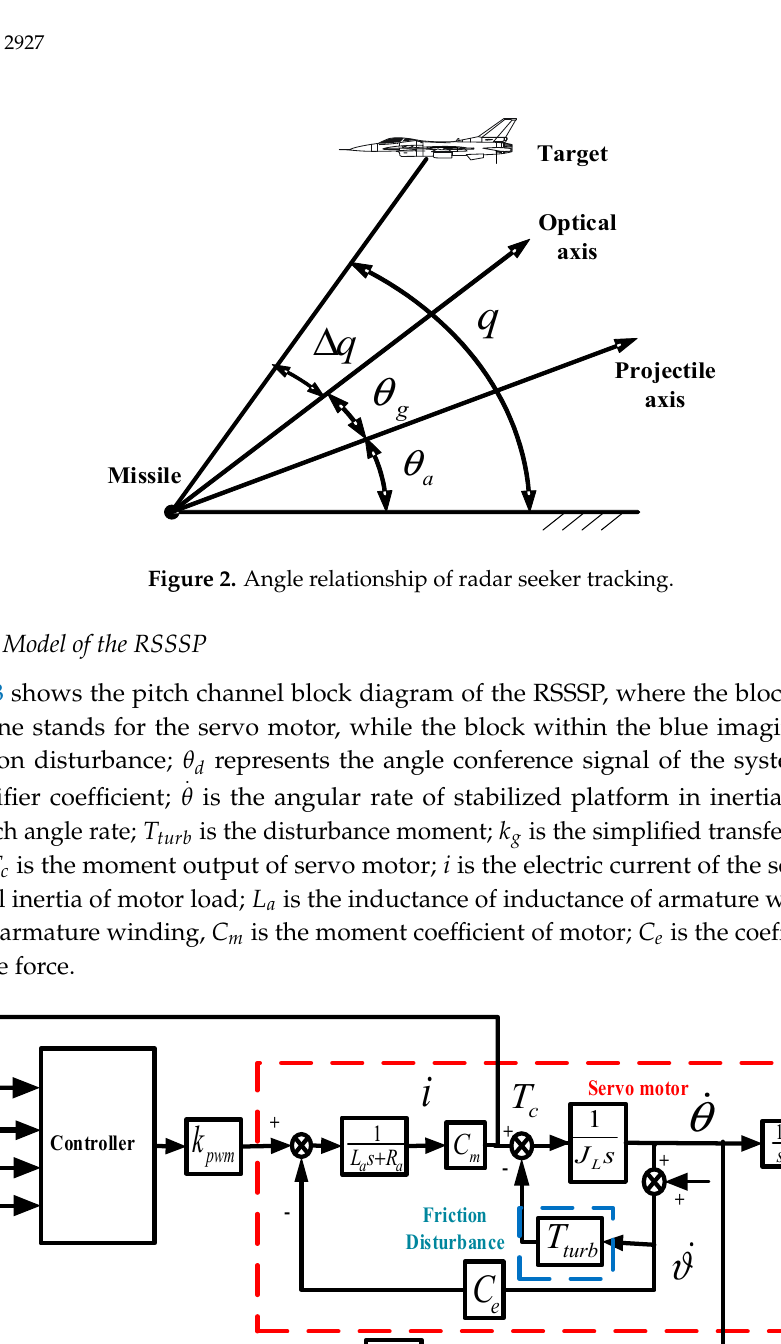
Figure 2. Angle relationship of radar seeker tracking.